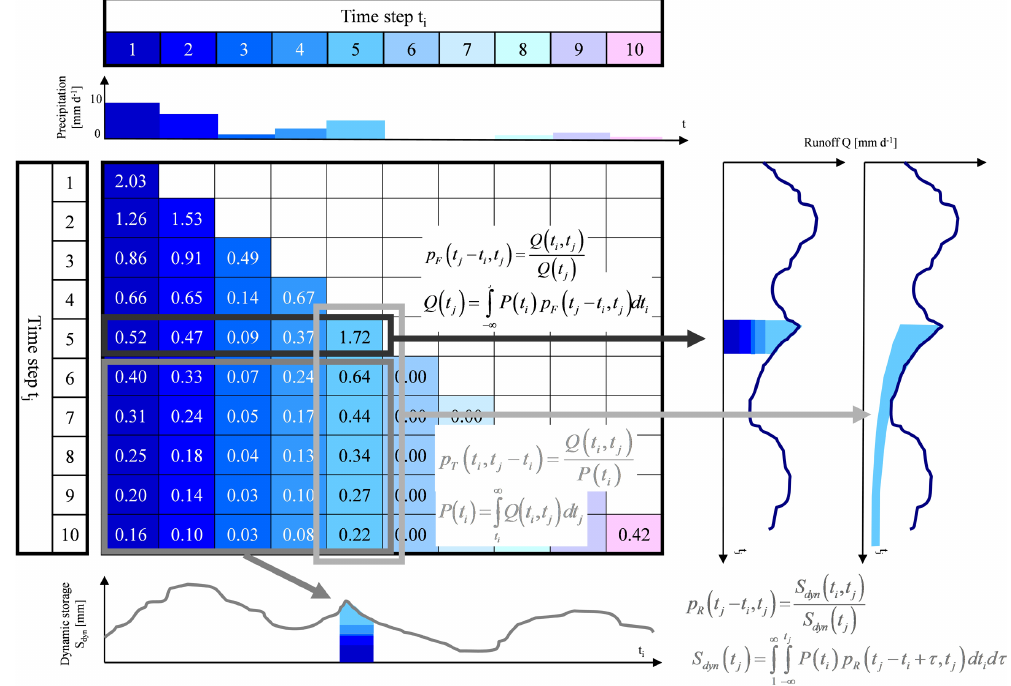
Fig. 4. Synthetic, illustrative example of the three different age distributions p F (flux age distribution), p R (resident age distribution) and p T (transit time distribution). Value in each cell of the grid indicates the runoff generated from precipitation entering the system at t i and exiting at t j . Note, that for simplicity, evaporation is omitted